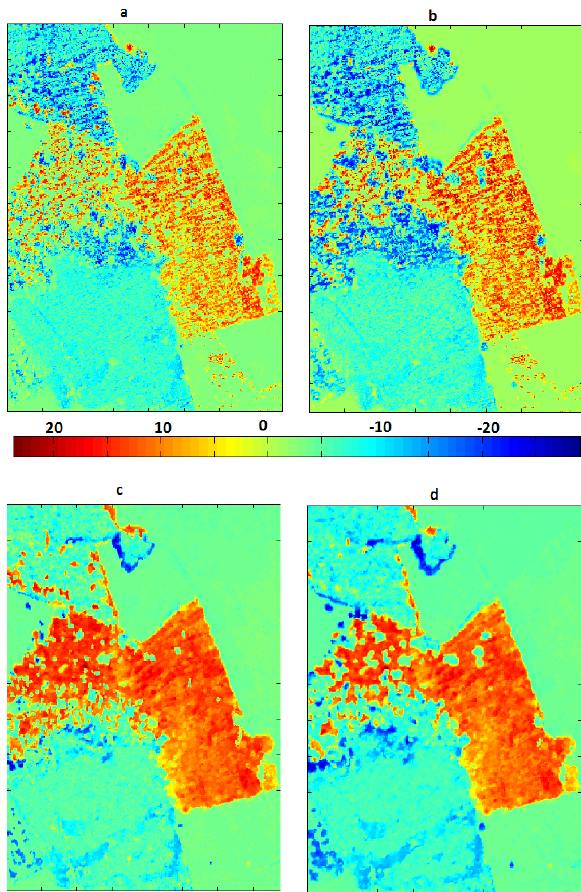
Figure 3. Difference surfaces from the area of Figure 2. a) ALS – after-storm UMD b) ALS – after-storm NGATE c) pre-storm NGATE – after-storm UMD d) pre-storm NGATE – after-storm NGATE. The colour bar in the middle shows the height colour